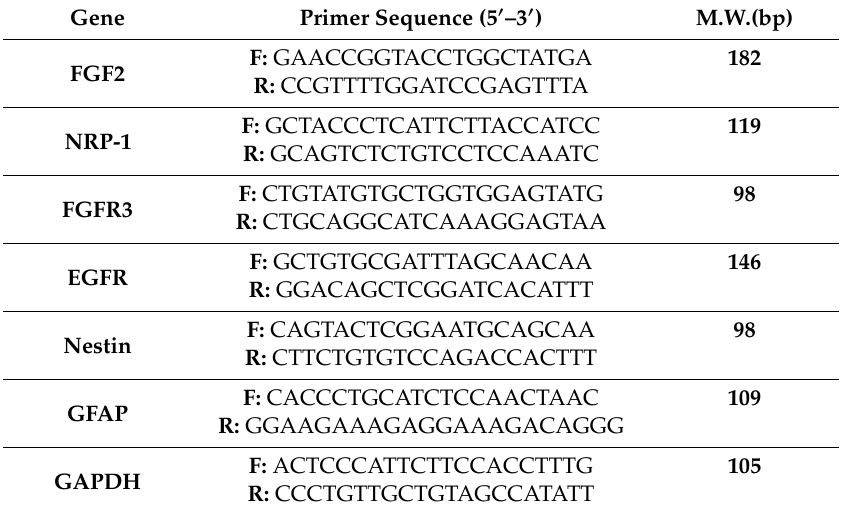
Table 1. Gene regulation examined via quantitative polymerase chain reaction